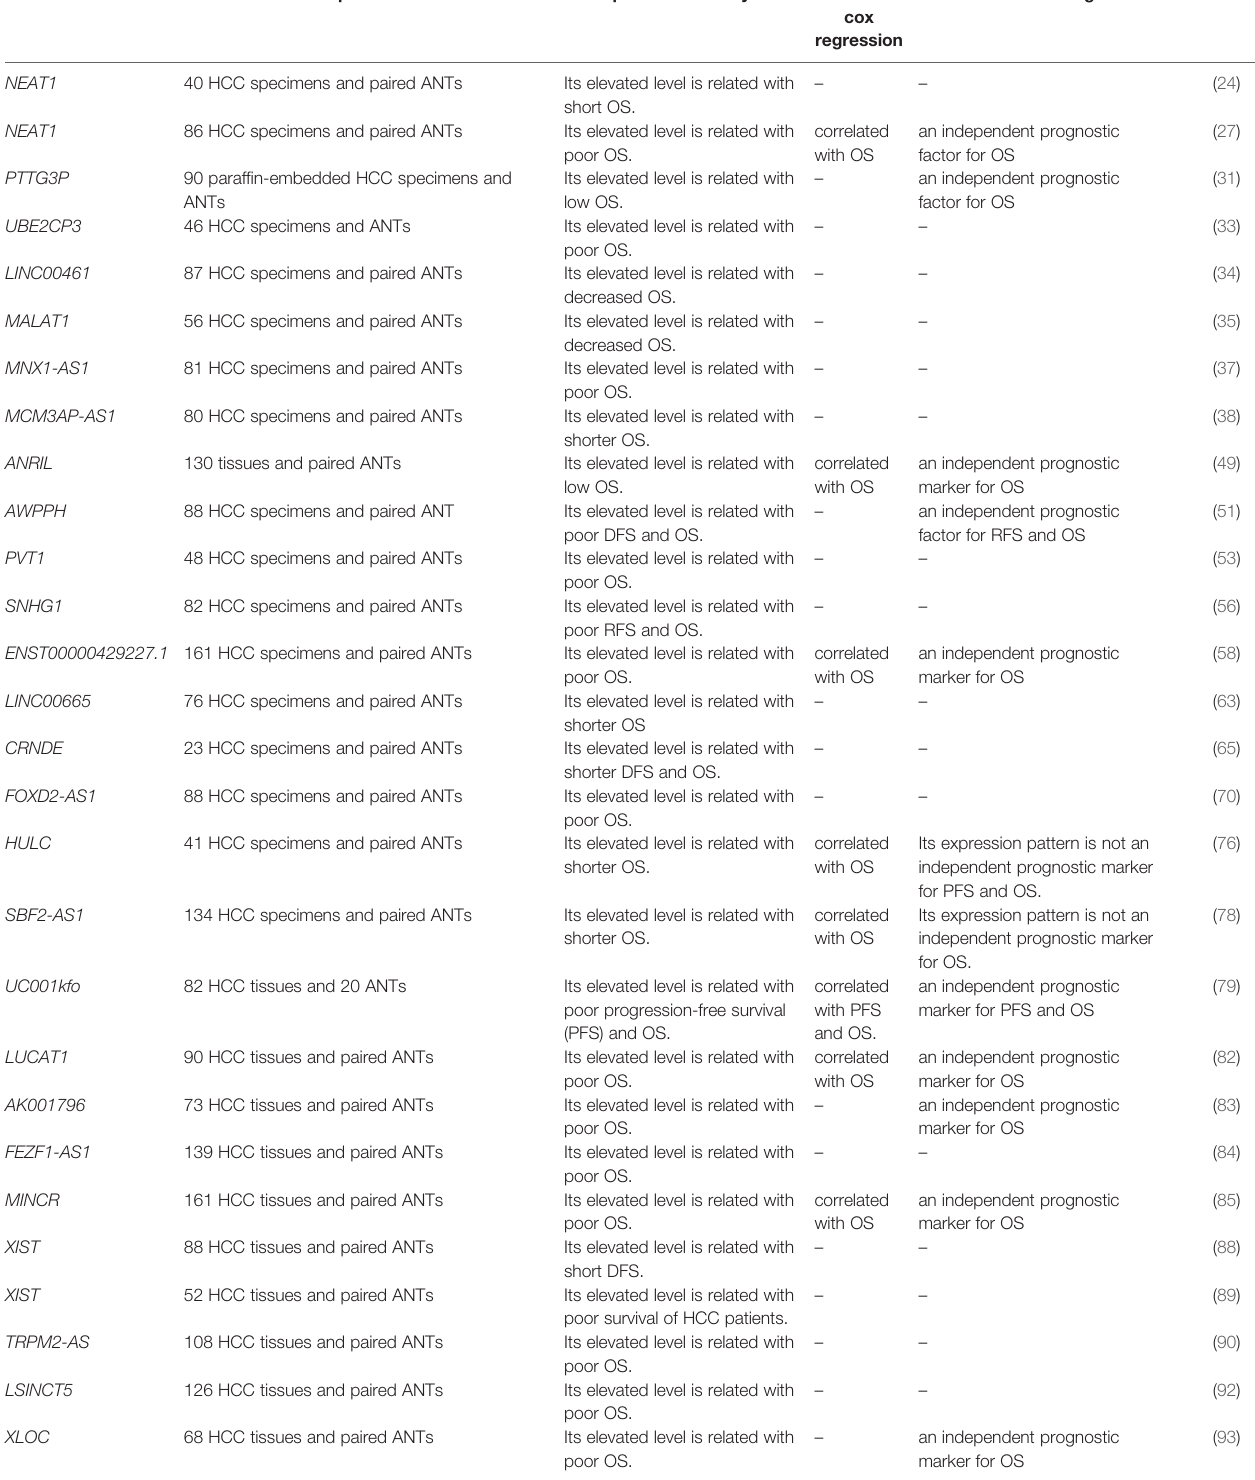
TABLE 3 | Prognostic role of lncRNAs in HCC (ANT, adjacent non-cancerous tissue; OS, overall survival; RFS, relapse-free survival; DFS, disease-free survival; PFS, progression-free survival; TTR, time to tumor